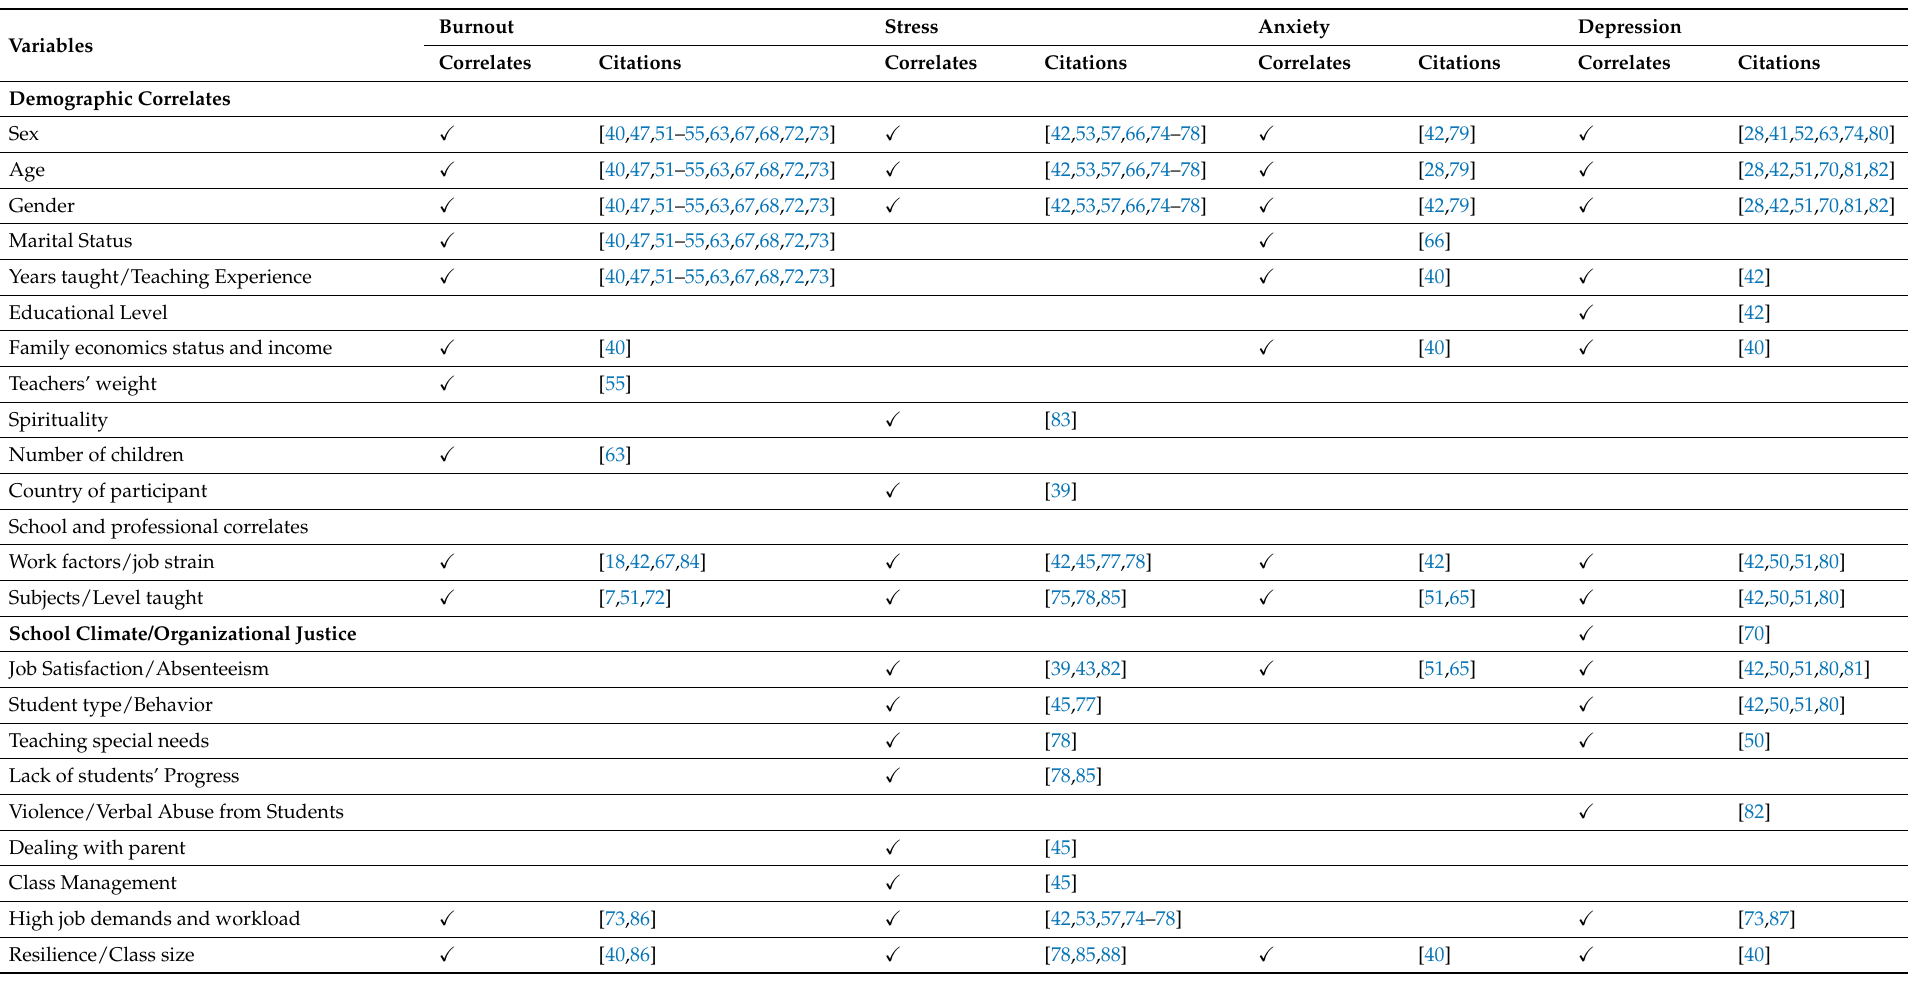
Table 1. Demographic, school and professional correlates of burnout, stress, anxiety and